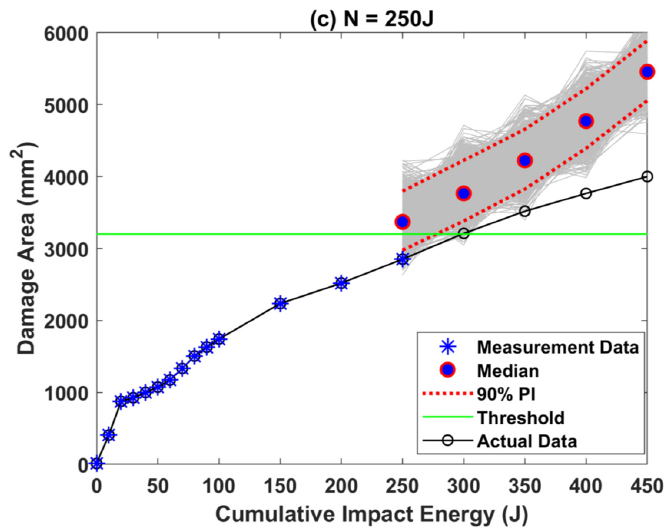
Figure 8. The prediction results for delamination dataset 2 using the Paris–Paris model with failure threshold assumed to be at 1200 mm 2 . The grey lines represent the particle trajectories for 1000 particles.